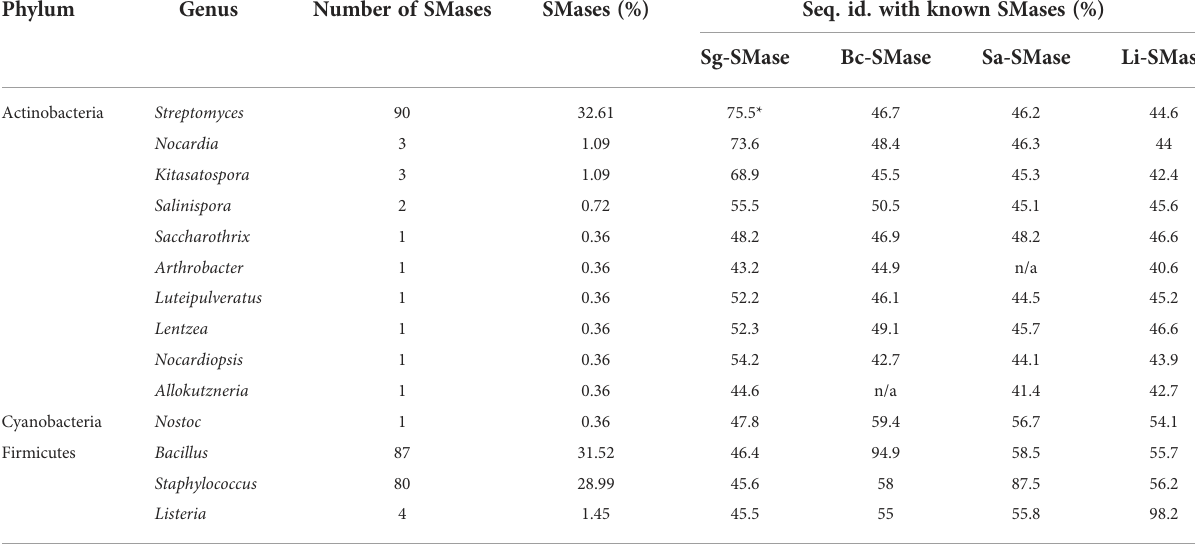
TABLE 1 Putative SMases identi fi ed from bacterial complete genomes. Phylum